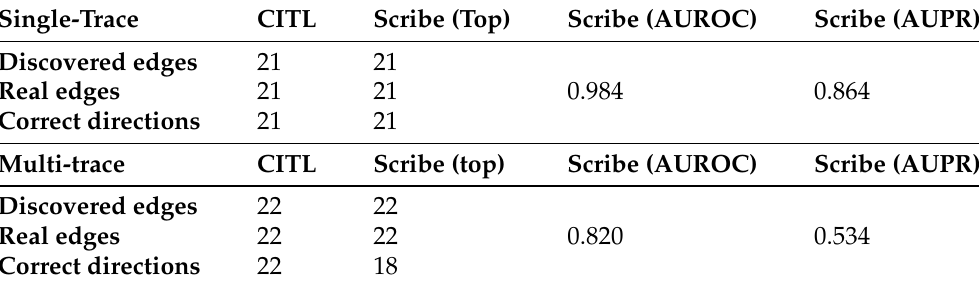
Table 2. Comparisons between CITL and Scribe in single-trace and multi-trace simulations. Single-Trace CITL Scribe (Top) Scribe (AUROC) Scribe (AUPR) Discovered edges 21 Correct directions 21 21 Multi-trace CITL Scribe (top) Scribe (AUROC) Scribe (AUPR) Discovered edges 22 22 Correct directions 22 18 sd: standard